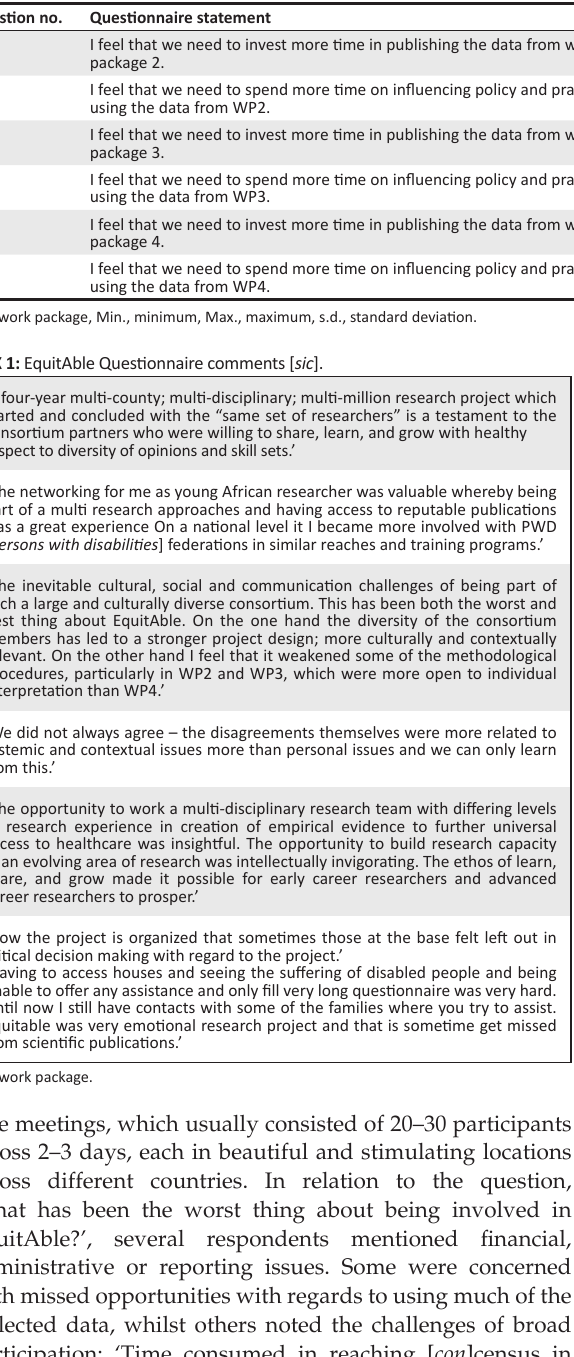
TABLE 5: EquitAble future. Question